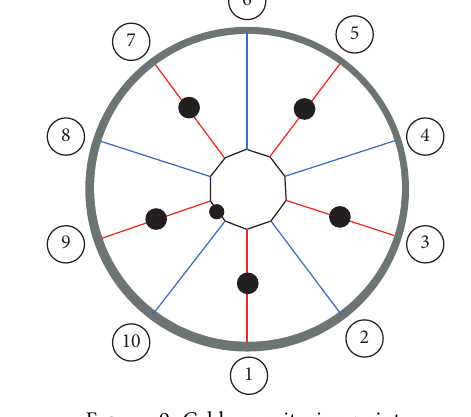
Table 3: Upper radial cable force ( N ).